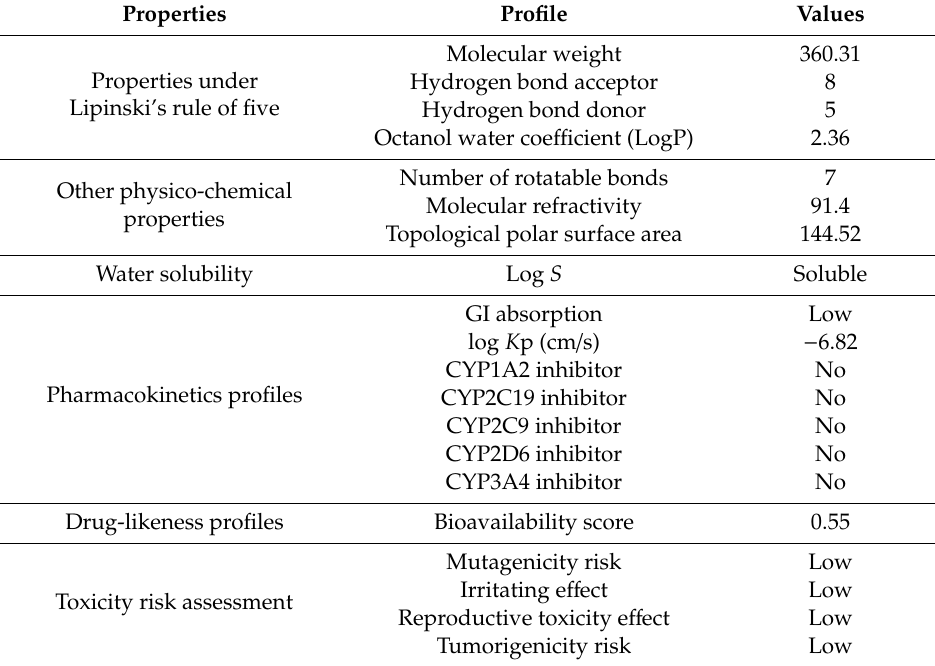
Table 3. In silico prediction of drug-likeness and ADMET profiles of